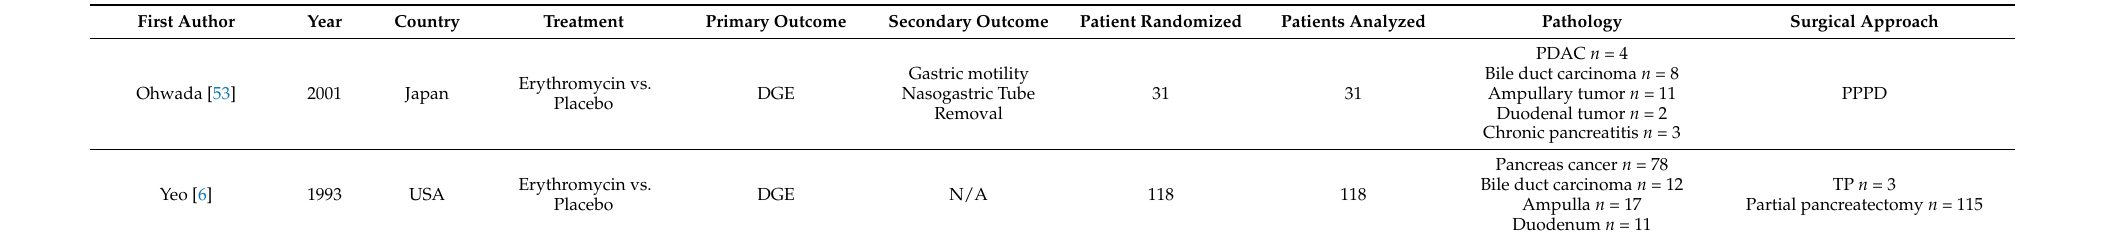
Table 3. Prokinetic Drug